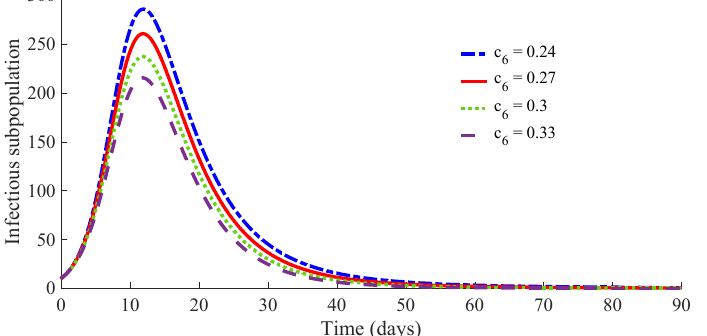
Figure 15. Time evolution of the infectious subpopulation for the four considered values of the control parameter c 6 . Table 2. Specifications of the model behaviour for the four considered values of the parameter c 6